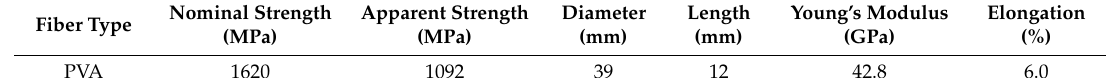
Table 3. Properties of PVA fiber.